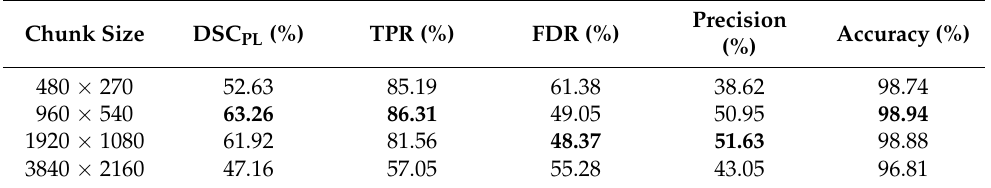
Table 4. Based on 60 images in the test dataset, the average of each performance parameter of Mask RCNN at different chunk sizes.